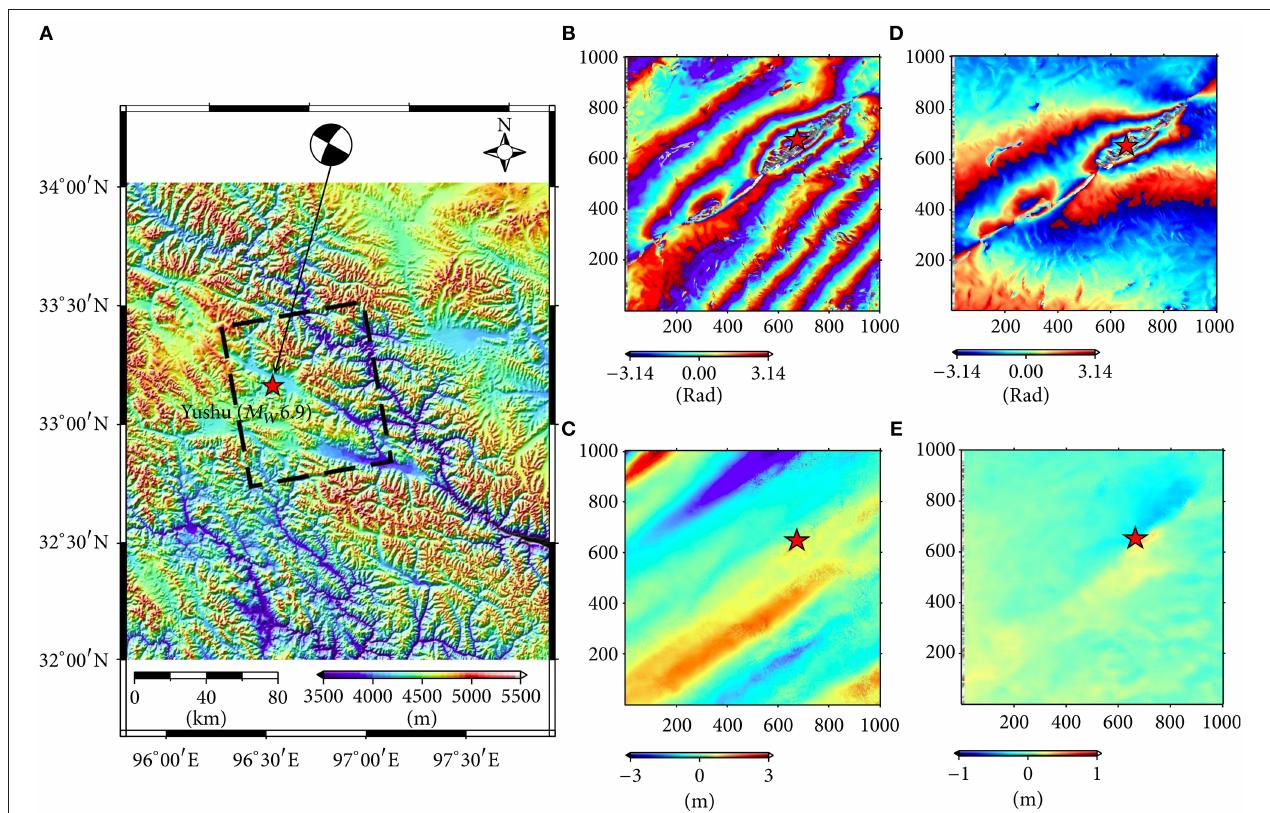
FIGURE 5 | (A) Topographic map of the area of the Mw 6.9 April 13th, 2010 Yushu, China, earthquake (epicenter shown with a red star). The black rectangle indicates the coverage of the ALOS-1 PALSAR Stripmap data (B,C) Wrapped DInSAR phase and offset tracking azimuth displacement for the January 15, 2010 – July 18, 2010 image pair. (D,E) Wrapped DInSAR phase and offset tracking azimuth displacement for the January 15, 2010 – April 17, 2010 image pair. Reproduced from Figure 4 in Zhu et al. (2017), distributed under the CC BY 4.0 license